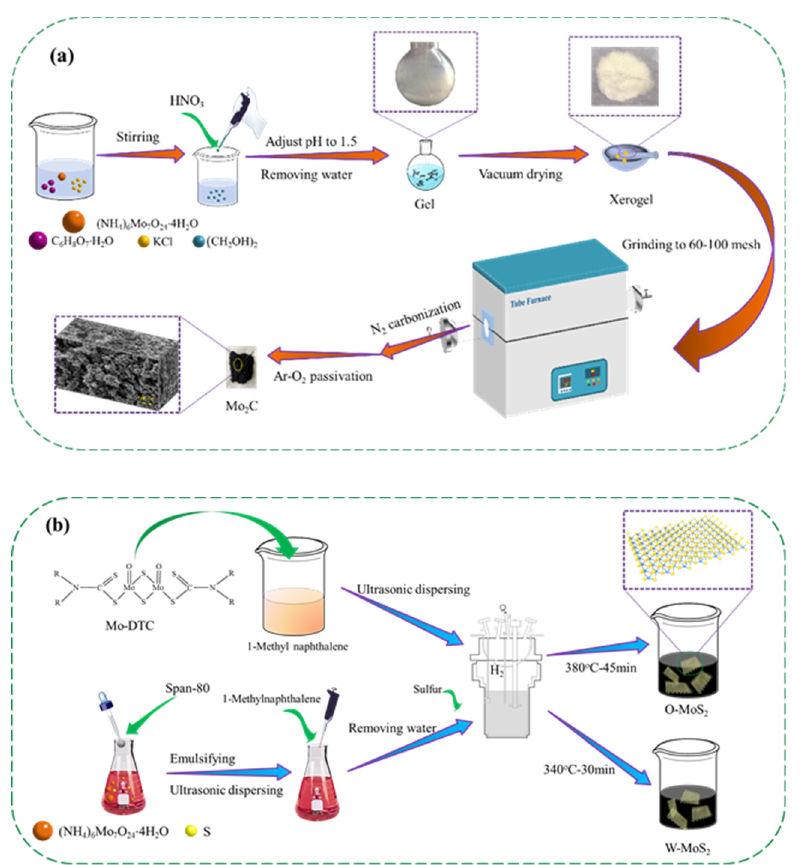
Figure 1. Schematic illustration of the preparation process of the catalysts, ( a ) Mo 2 C, and ( b ) O-MoS 2 and W-MoS 2 .